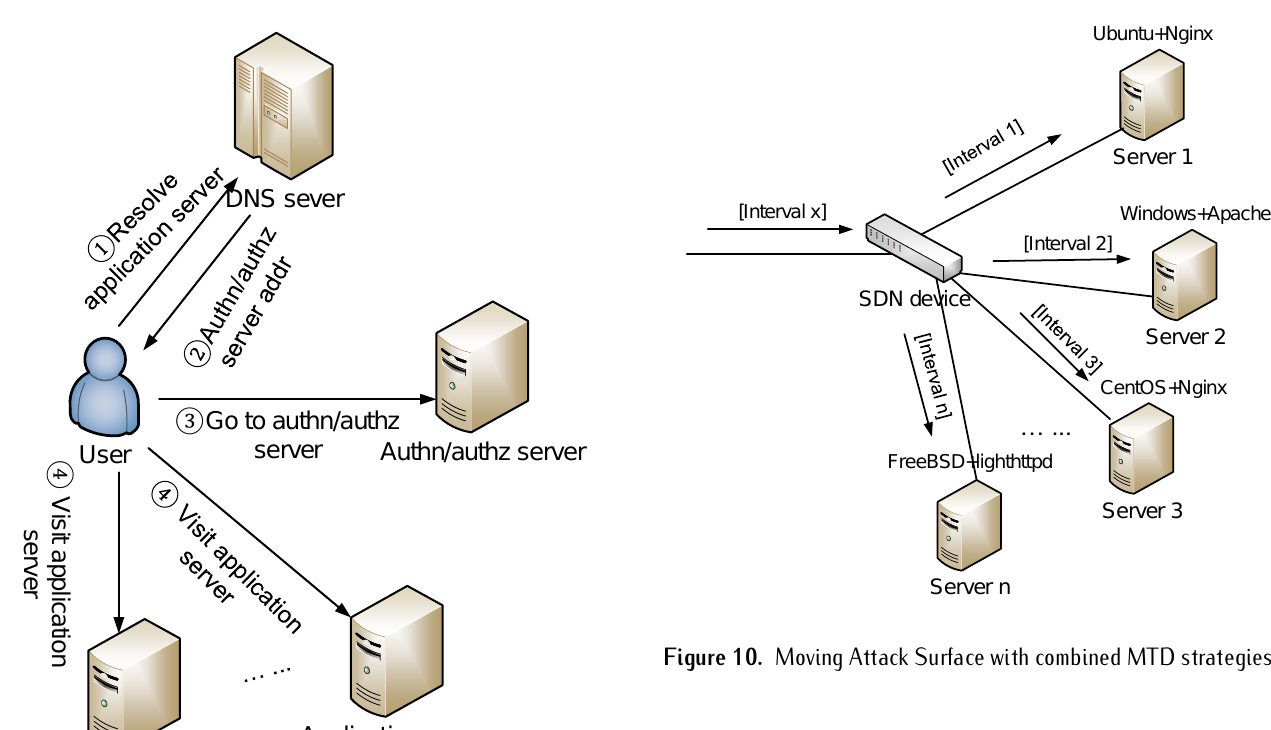
Diversification, and Network Tra ffi c Reflection to provide a Moving Attack Surface [14] [15]